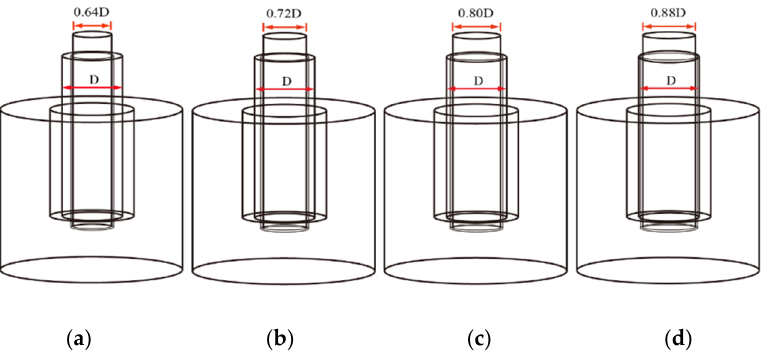
Figure 2. Double vortex-finder hydrocyclone in different diameter configurations. ( a ) 0.64D ( b ) 0.72D ( c ) 0.80D ( d ) 0.88D.